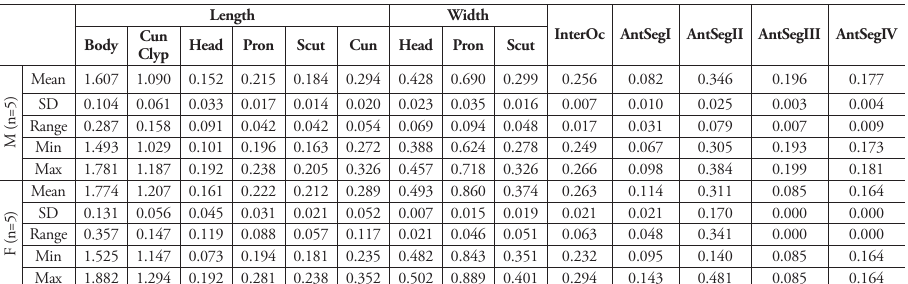
Table 1. Measurement of key characters of Henryhalticus philippinensis . All measurements given in mil- limeters. Mean, standard deviation, range, minimum, and maximum values given for each species. Ab- breviations: CunClyp = maximum length between apex of clypeus and tip of cuneus, Pron = pronotum, Scut = scutellum, InterOc = Interocular distance, AntSegI–IV = antennal segment